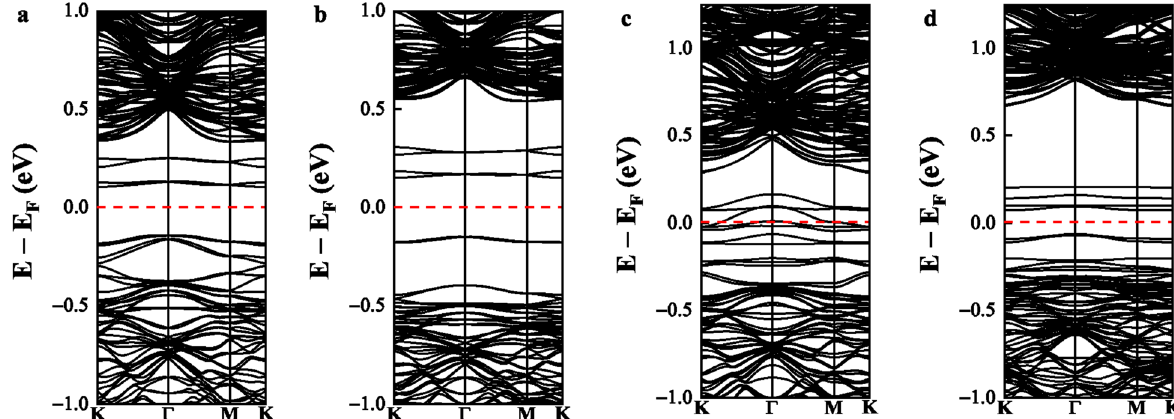
Fig. 5 In fl uence of vacancies on PtTe 2 band structure. Band structure of ML PtTe 2 with a single Te vacancy ( a , b ) and single Pt vacancy ( c , d ) obtained from GGA + SOC and GGA-1/2 + SOC approaches. Energies are referenced to the Fermi energy (red dashed